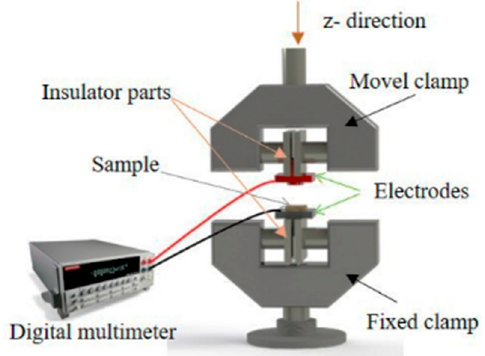
Figure 1. Schematic representation of the experimental configuration of the clamps for the compression experiments with simultaneous electrical measurements for electro-mechanical response evaluation of the